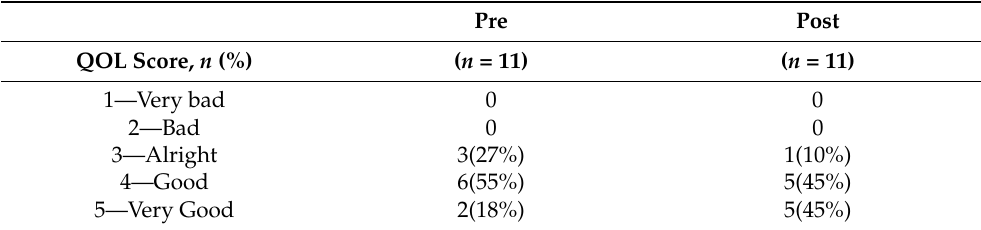
Table 2. Single Item-global quality of life (QoL) Score Summary Statistics. Pre